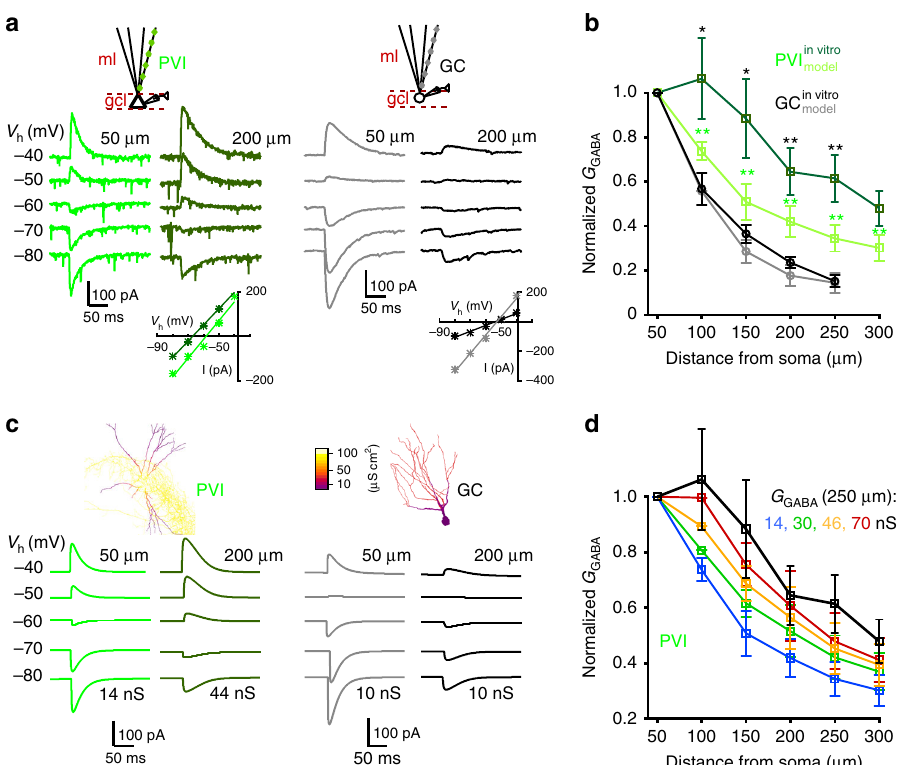
Fig. 5 GABA A R-mediated conductances are enriched at distal PVI but not at GC dendrites. a Whole-cell voltage-clamp recordings from PVIs and GCs during RubiGABA uncaging at different positions along an apical dendrite (green squares). Holding potential ( V h ) was systematically changed to calculate the slope conductance underlying uncIPSCs ( G GABA ) from the resulting current − voltage relationship (lower insets). c PVI and GC single-cell models were used to evaluate the in fl uence of signal attenuation on somatically measured G GABA . Insets, morphologies of representative PVI (left) and GC (right) used for single-cell computations. Color code represents membrane conductance distributions. GABAergic synapses were included along an apical dendrite (50 µ m steps). Traces show somatic IPSPs evoked at somato-dendritic distances of 50 and 200 µ m at various V G h in model PVIs (left) and GCs (right). GABA was determined from current − voltage relationships as in experiments ( a ), with a linear somato-dendritic E GABA gradient constrained by in vitro results ( fi ve PVI and fi ve GC model cells; Supplementary Fig. 6b). b Experimentally obtained G GABA was normalized to the most proximal uncaging site (50 µ m) and plotted as a function of somatic distance (dark green and black lines, six PVIs and fi ve GCs, respectively). Experiments were reproduced in PVI (bright green) and GC (gray) models with uniform somato-dendritic G GABA (14 and 10 nS for PVIs and GCs, respectively). Note, GC models closely reproduce the attenuation of inhibitory signals observed in vitro but not PVI models. d Plot as in ( b ) for PVI models with different somato-dendritic G GABA distributions. Black line depicts in vitro data, blue line de fi nes models with uniform G GABA distribution. Green, yellow and red traces depict results from models with different linearly increasing G GABA gradients (numbers refer to G GABA at 250 µ m, while at 50 µ m the 14 nS conductance was kept constant). Note, a linear increase of G GABA from 14 nS at 50 µ m to >46 nS at 250 µ m was the best fi t to our in vitro data (yellow, red). Circles and squares with connecting lines depict mean ± s.e.m. * p ≤ 0.05; ** p ≤ 0.01. Green asterisk refers to comparisons between in vitro and model PVI data; black asterisk refers to comparisons between PVIs and GCs in